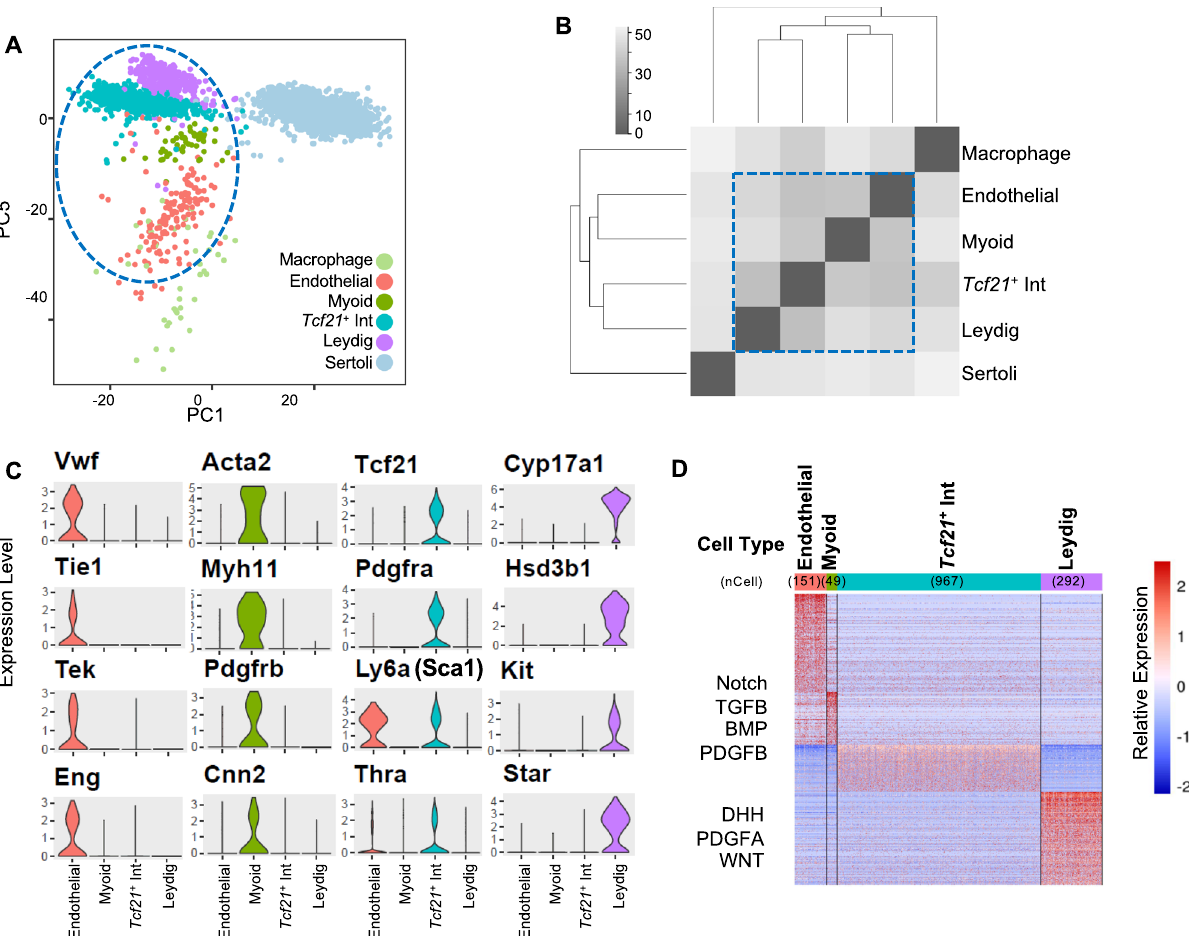
Fig. 1 Identi fi cation and characterization of a Tcf21 -expressing interstitial somatic cell in the adult testis. A Visualization of 6 somatic cell types in PC space. Data reprocessed from Green et al. 13 . Note somatic cell populations were enriched using a combination of cell surface markers or transgenic lines, therefore cell frequencies in PCA plot are not representative of in vivo. B Heatmap of dissimilarity matrix of somatic cell types illustrates high similarity for the Tcf21 + interstitial population with 3 somatic cell types — myoid, Leydig, and endothelial cells. Gray scale indicates Euclidean distance. C Violin plots of representative markers for endothelial, myoid, Tcf21 + interstitial population, and Leydig cells. D Heatmap of differentially expressed markers for each of the 4 closely related somatic cell types — endothelial, myoid, Tcf21 + interstitial population, and Leydig